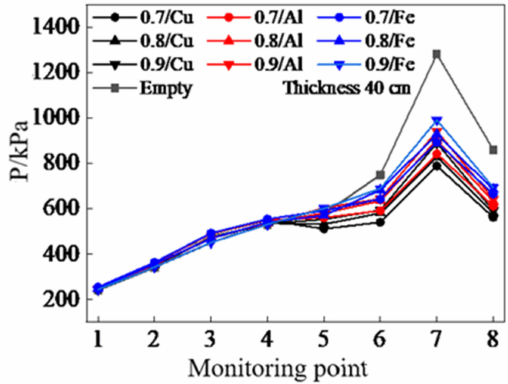
Figure 21. Maximum overpressure at each monitoring point.